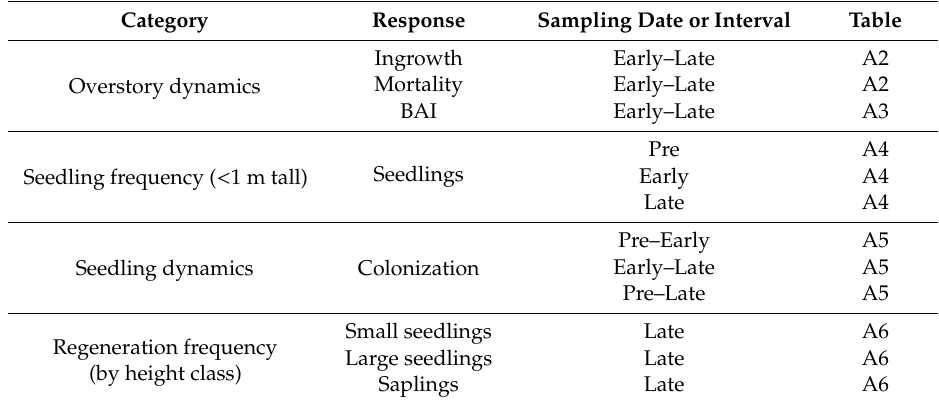
Table A1. Contents of Tables A2–A6, which contain detailed results of individual linear or generalized linear models. For a comparative summary of model results, see Table 2 (main text).